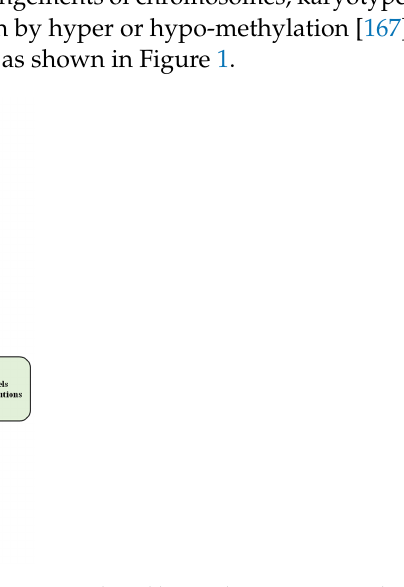
Figure 1. Mechanism of somaclonal variation induced by oxidative stress in plants cultivated in vitro.